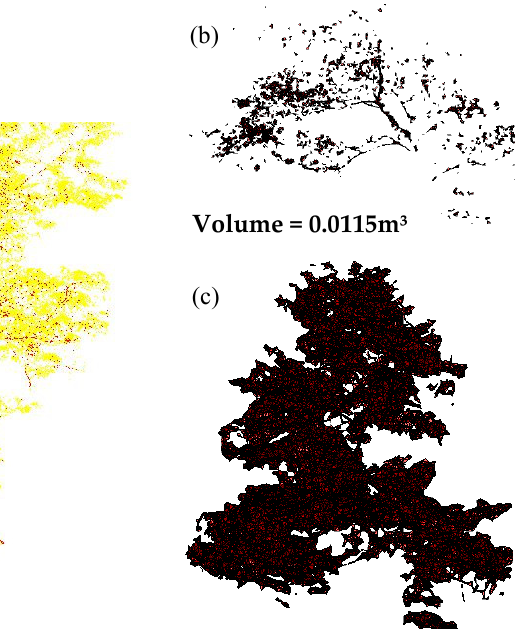
Figure 9. Alpha applied to the convex hull to refine the detail volume estimation for crown components.